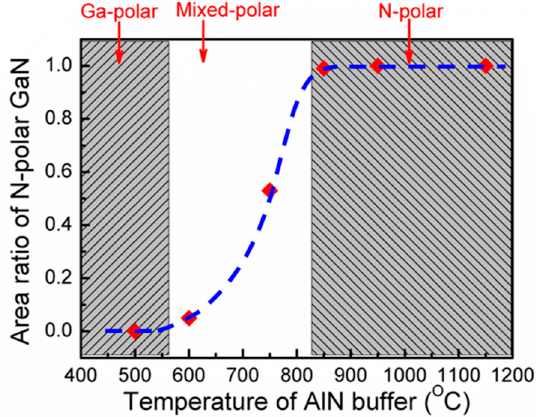
Figure 2. The dependence of the area ratio of N-polar on the growth temperature of the AlN buffer.